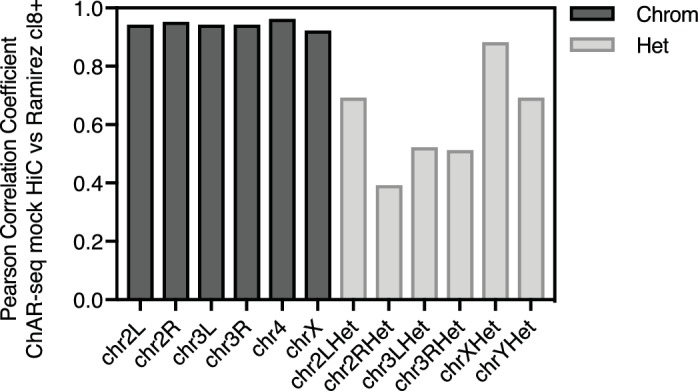
ChAR-seq protocol preserves genome organization.Bar plot of Pearson correlation coefficients by chromosome calculated by comparing Hi-C data from CME-W1-cl8+ (Ramírez et al., 2015) to our Hi-C/Mock-ChAR libary, where no bridge was added and biotin fill-in was performed following DpnII digestion, but prior to ligation.